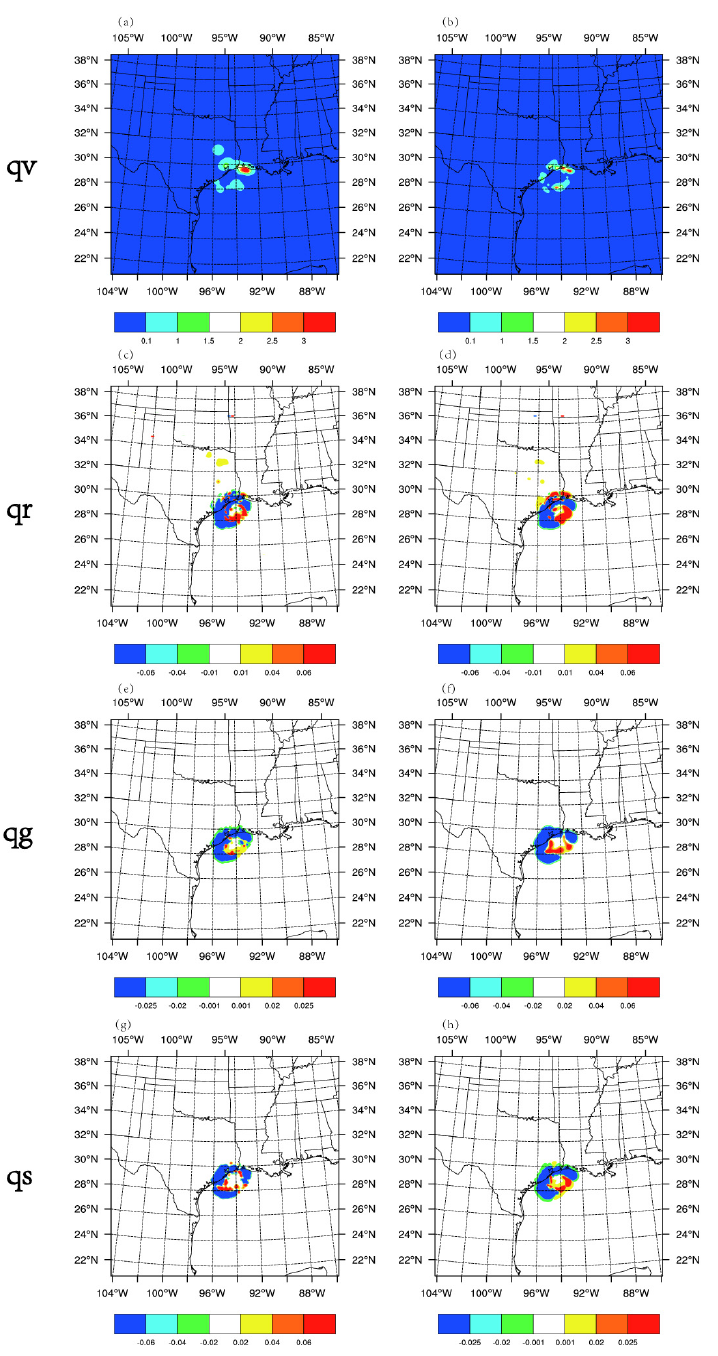
Figure 8. DA_Radar ( a , c , e , g ) and DA_Radar_CVH ( b , d , f , h ) water vapor increment (unit: kg/m 2 ) of q v (line 1), q r (line 2), q g (line 3), q s (line 4) at 0300 UTC on 13 September.